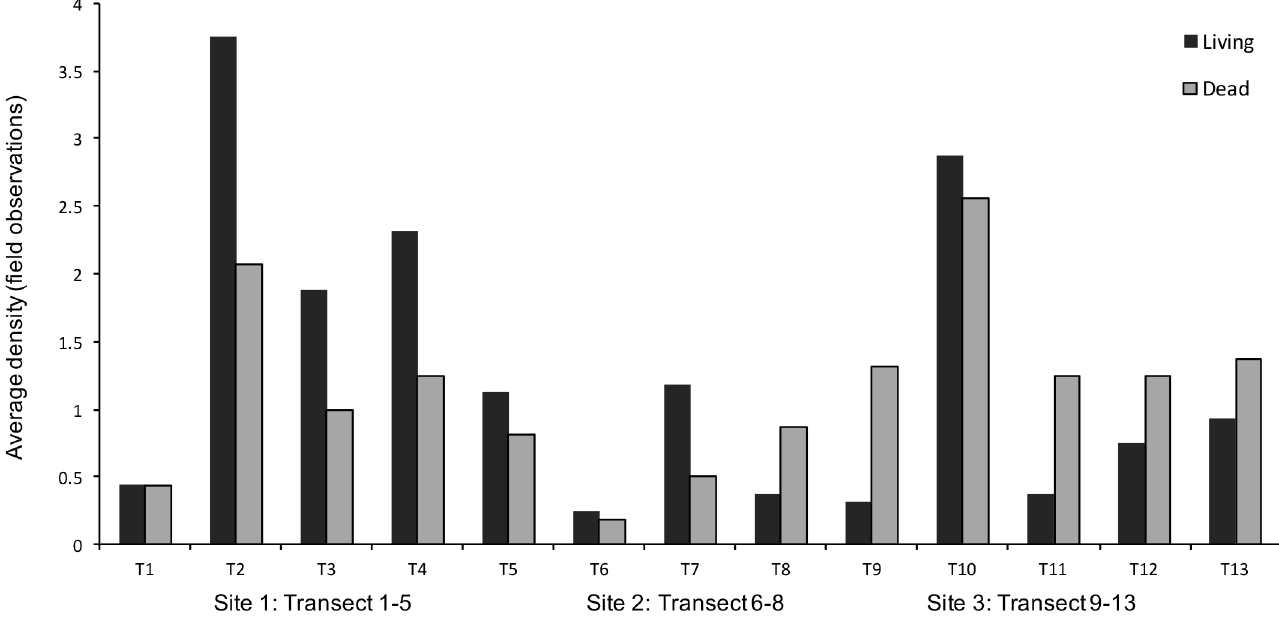
Fig 4. The distribution of oystersamong transects. Abundance of living and deadoysters in each transect at the three sites, determined in the field. Transect 1–5 from Site 1, Lo¨kholmen;transect 6–8 from Site 2, L å ngholmen;and transect 9–13from Site 3, G å sholmen.